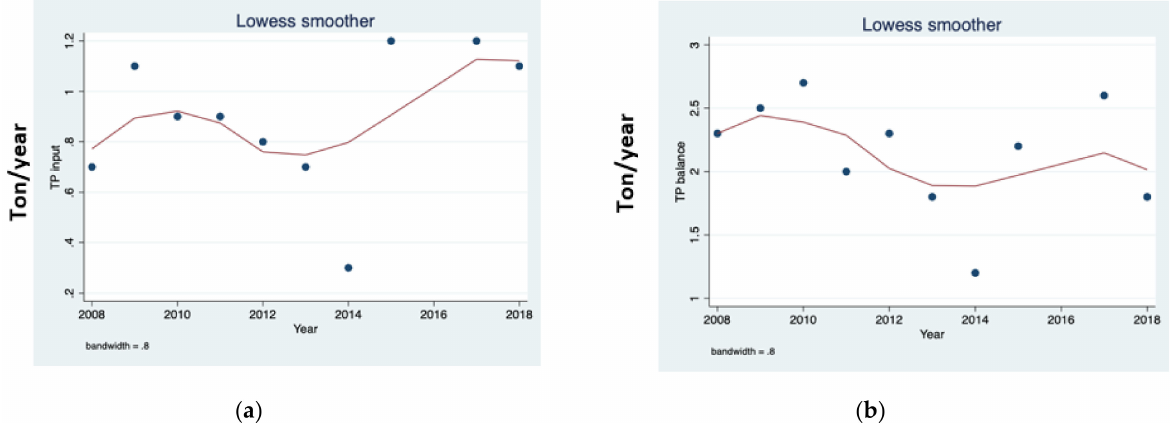
Figure 12. LOWESS smoother plot of trend in changes in annual loads (tons/year) of TPin ( a ) and TPbalance ( b ) during